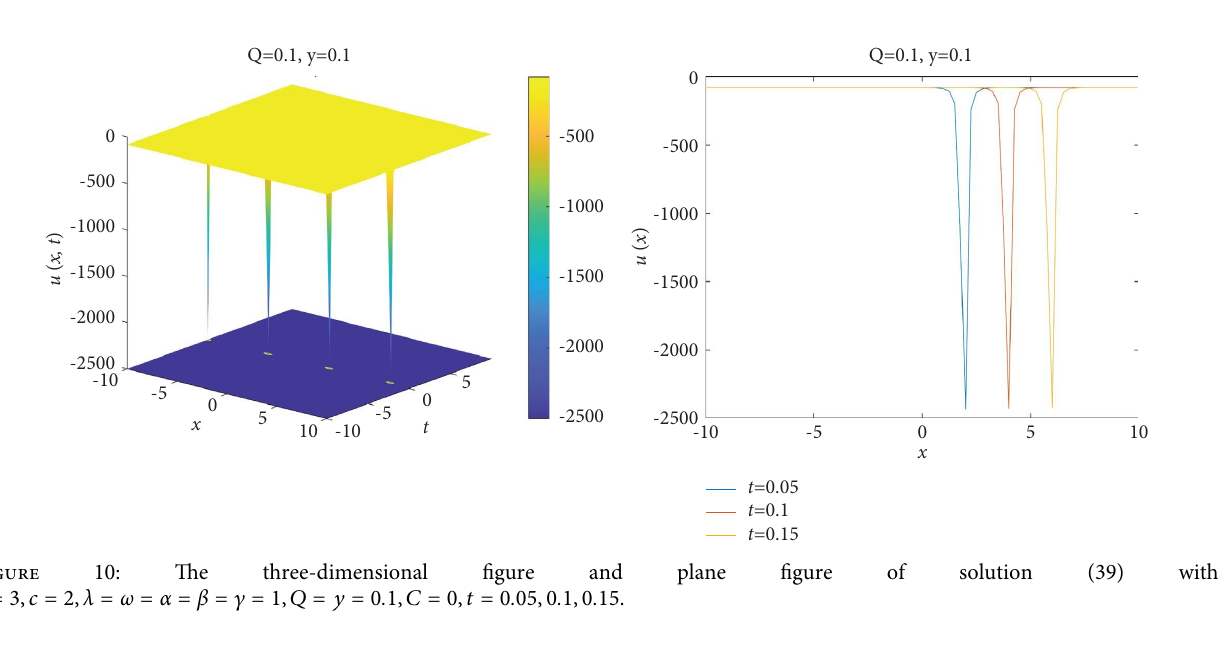
9: Te three-dimensional fgure and plane